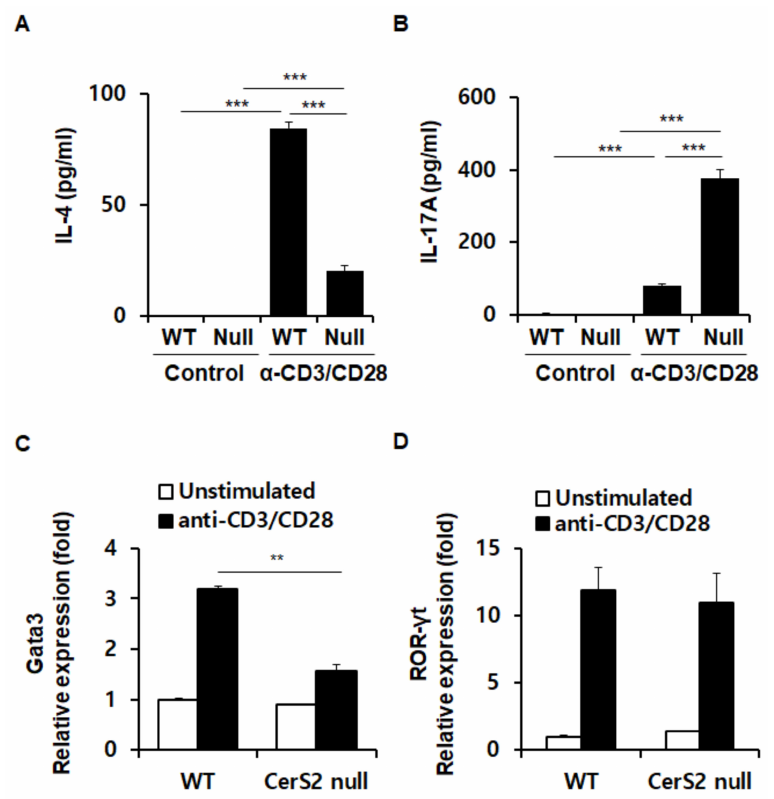
Figure 3. WT-CD4+T cells and CerS2 null-CD4+T cells differ in induction of cytokines and corre- sponding transcription factors. Splenic CD4+ T cells isolated from wild type and CerS2 null mice were cultured in the presence or absence of anti-CD3/anti-CD28 antibodies ( α -CD3/CD28) for 3 days, and the protein levels of ( A ) IL-4, and ( B ) IL-17 in cell culture supernatants were analyzed by ELISA. mRNA expression of ( C ) Gata3, the Th2 cells polarizing transcription factor, and ( D ) ROR γ t, the Th17 cell polarizing transcription factor, were measured using quantitative real-time PCR. Data are expressed as the mean ± SEM ( n = 5). ** p < 0.01; *** p < 0.001. Null indicates CerS2 null mice. Statistical significance was analyzed using the two-way analysis of